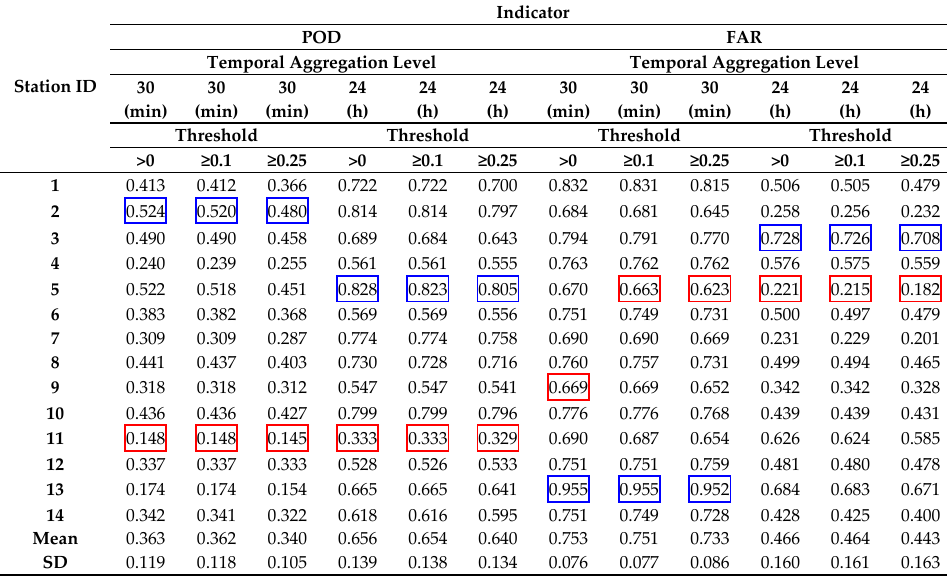
Table 5. Results of the precipitation detection capacity analysis (POD and FAR).